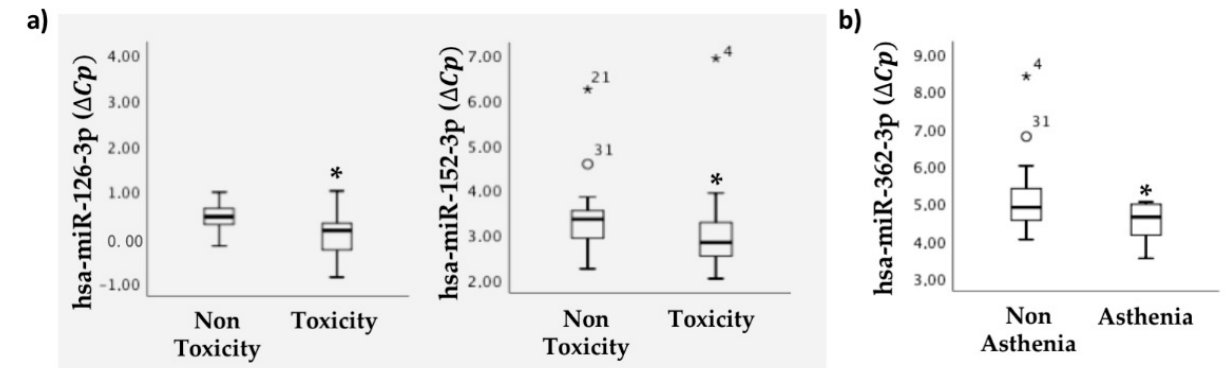
Figure 3. Serum miRNAs correlate with treatment toxicity. miRNAs selected from profiling were validated by individual qRT-PCR. Statistical association of selected serum miRNAs with ( a ) toxicity associated with regorafenib treatment (non-toxicity, n = 18; toxicity, n = 23) and ( b ) asthenia (non-asthenia, n = 30; asthenia, n = 11). miRNA levels are expressed as the delta-crossing threshold (DCT); the mean of miR-103a-3p Cq and miR-30c-5p Cq was used as a normalizer Cq. Only miRNAs showing a statistically significant association between the two represented categories are shown. Data are presented as the median and interquartile range, with * p < 0.05, ° outliers values.